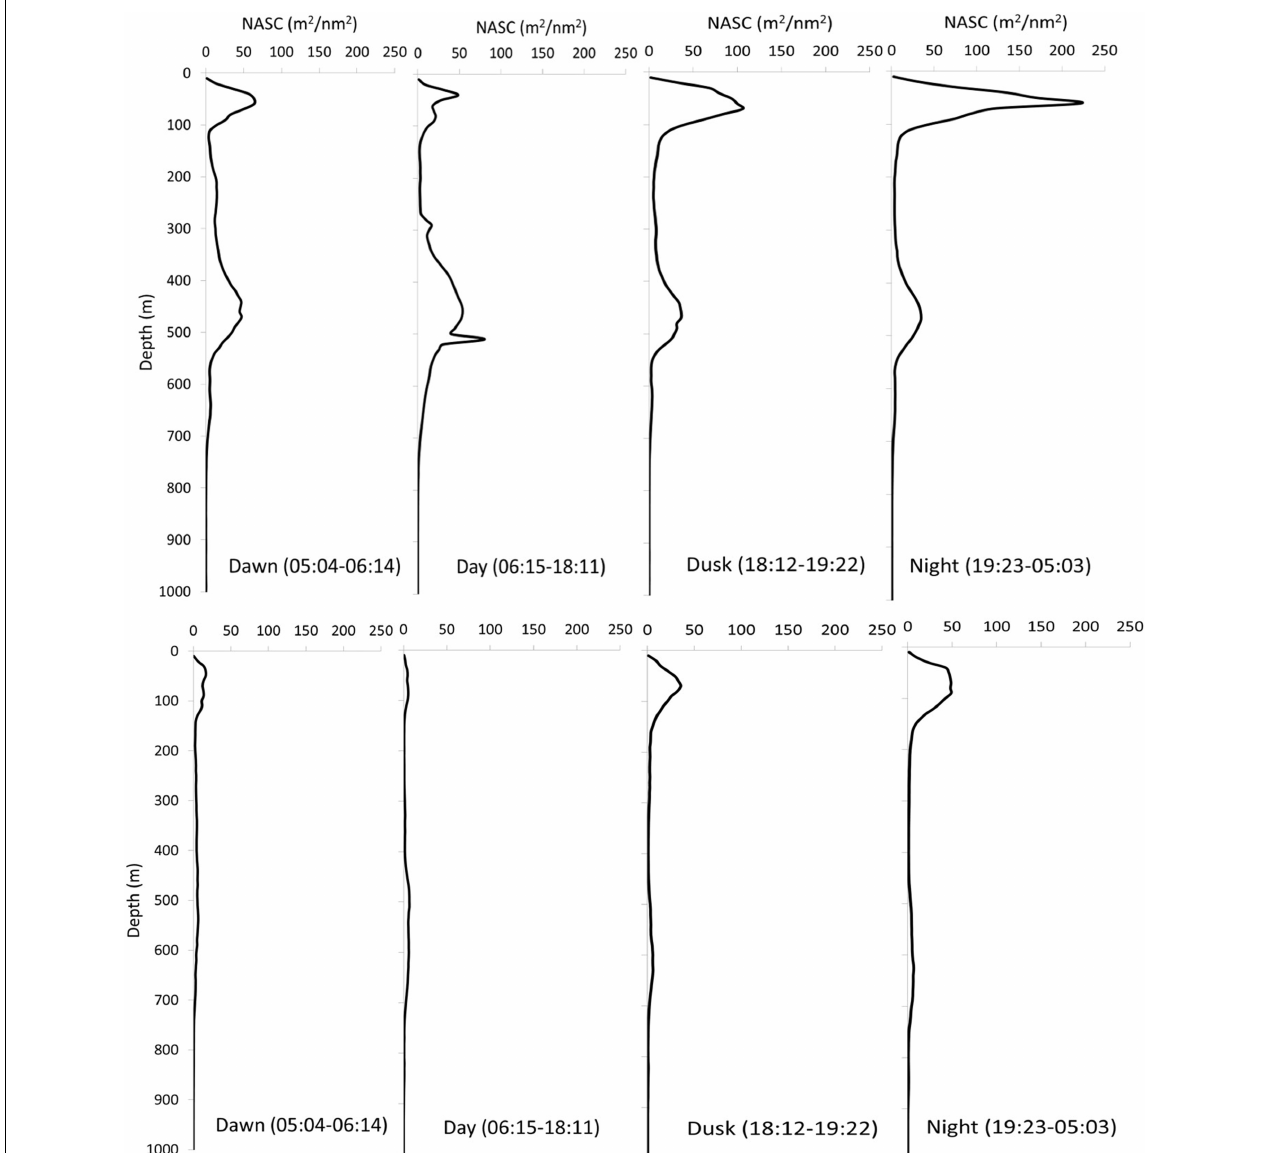
FIGURE 5 | Vertical distribution of acoustic scatterers based on dawn, day, dusk, and night. The average sunrise and sunset times in Seychelles during the survey period were 6:15 and 18:12, respectively. The top panels correspond to SCTR and the bottom panels to non-SCTR. below ∼ 200 m in the SCTR and ∼ 300–500 m in the non- in the non-SCTR region, was found below the